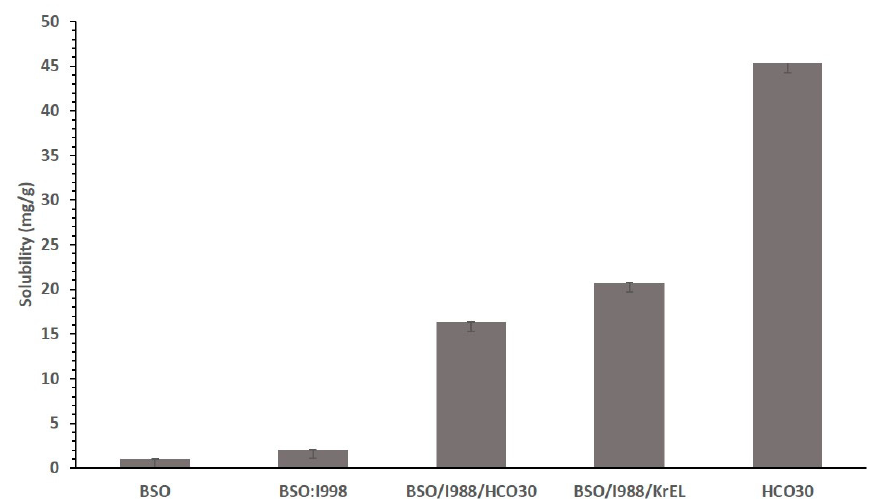
Figure 4. Effect of surfactants on the solubility of the CUR bioactive formulations. The excipients were mixed as % ( w / w ). The formulations were represented by BSO (100%)-F1, BSO/I988 (70/30%)-F2, BSO/I988/HCO30 (35/15/50%)-F3, BSO/I988/KrEL (35/15/50%)-F4, and HCO30 (100%)-F7, respectively.